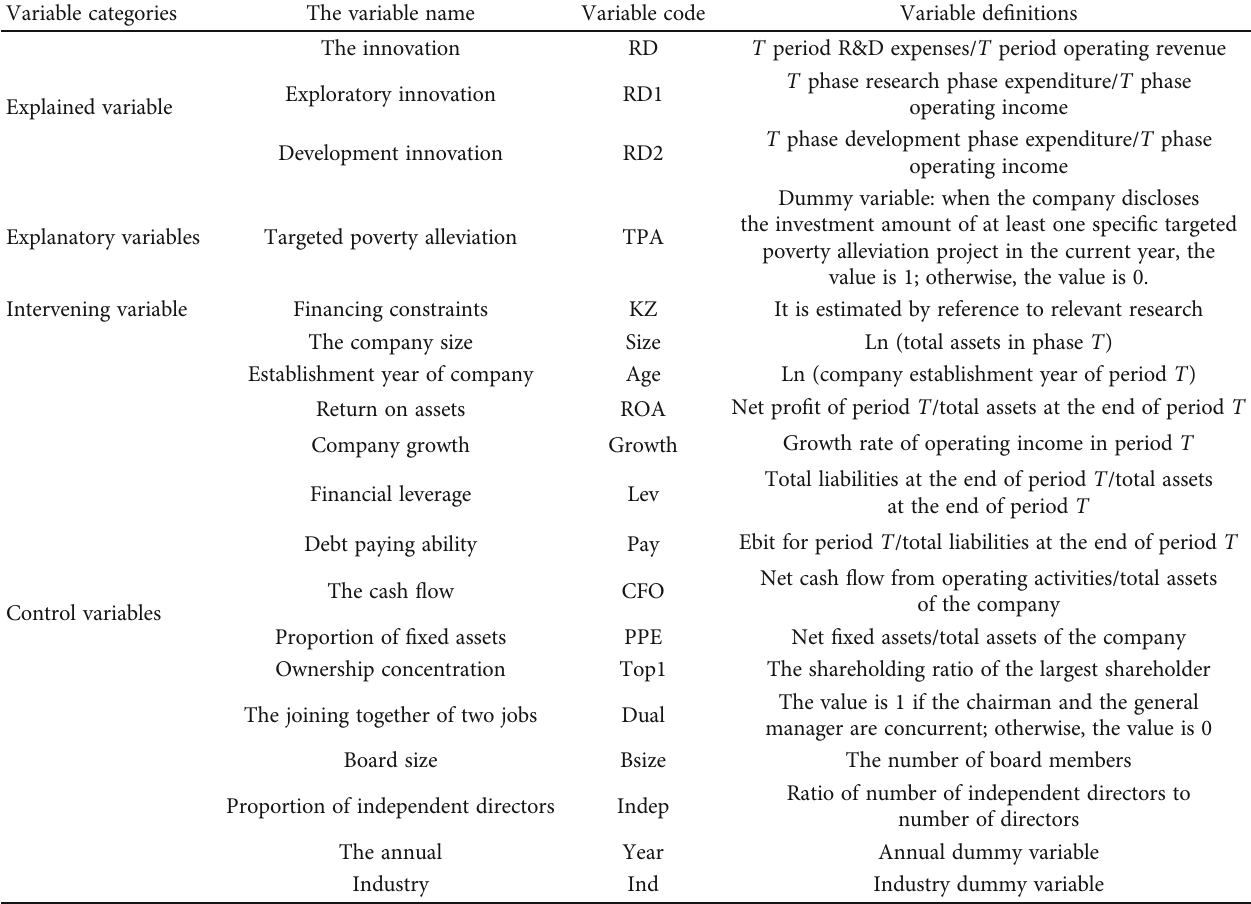
Table 1: Variable de fi nition table.